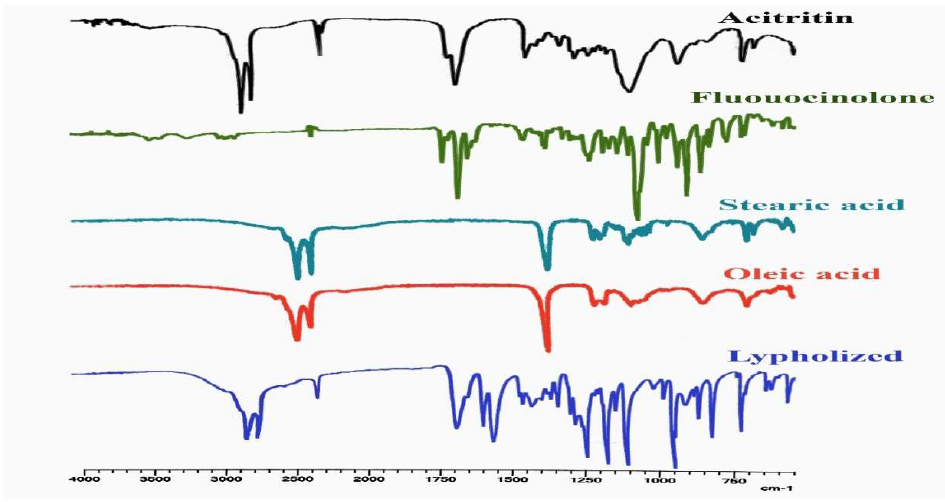
Figure 6. FTIR analysis of fluocinolone, acitretin, stearic acid, oleic acid and lyophilized FLU–ACT- coloaded NLCs.